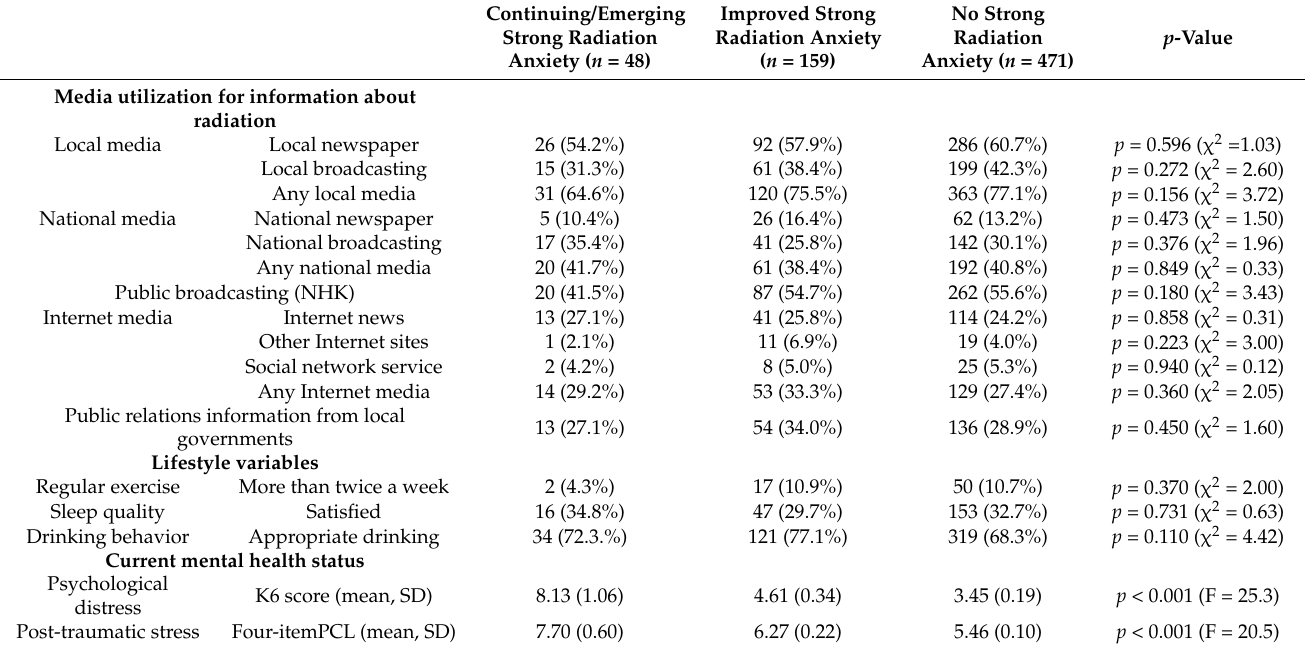
Table 5. Simple tabulation of media utilization, lifestyle variables, and current mental health status of those with continu- ing/emerging, improved, and no strong health-related radiation